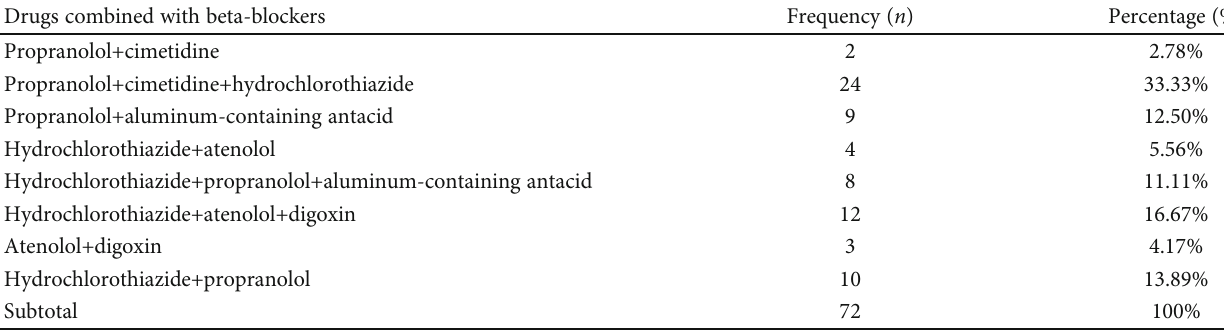
Table 2: Frequently combined drugs with beta-blockers in the medical wards of NGH within 2 years. Drugs combined with beta-blockers